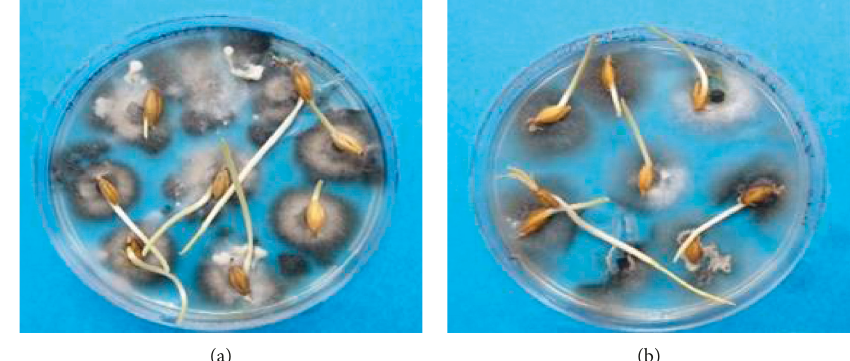
Figure 5: The display of pathogenicity of the two B. sorokiniana isolates on barley seeds (cultivar Arna). (a) P-08 isolate; (b) P-15